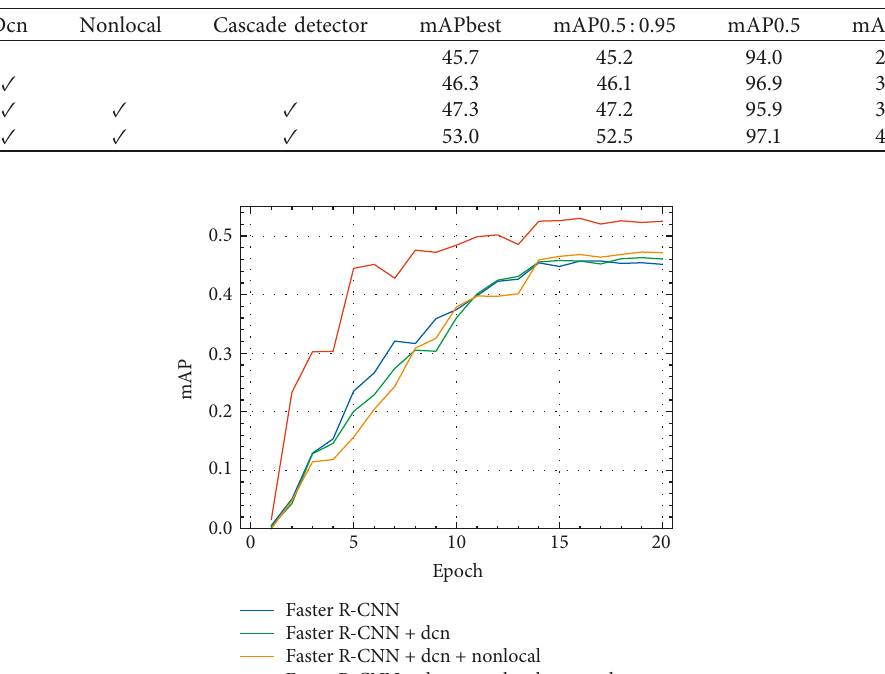
Table 2: Ablation comparison experiment of retrained Faster R-CNN.